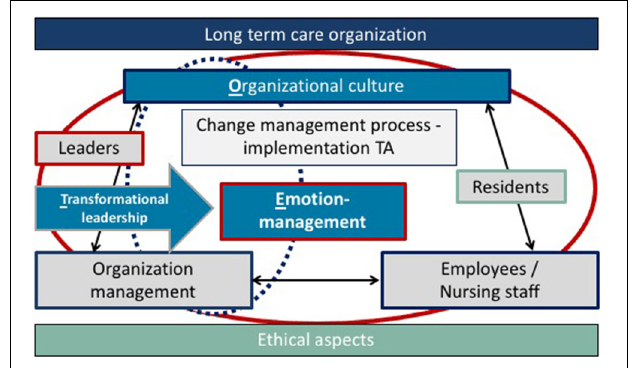
FIGURE 3 | Implementation of technical assistance and transformational leadership with emotion-management in nursing practice—TEO (own